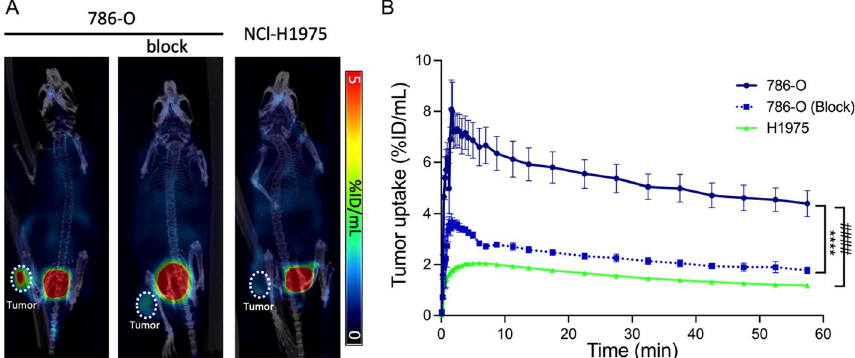
Fig. 3 PET/CT imaging using [ 68 Ga]Ga-NOTA-anti-CD70 VHH fragment— A Representative coronal µPET/ CT images (30–60 min post injection timeframe summed activity, slice thickness 0.78 mm) of mice bearing CD70 high (786-O (left panel) and with block (middle panel)) and CD70 low tumors (NCl-H1975, right panel). B Time-activity curves for radiotracer distribution in the tumors are shown. (%ID/mL % injected dose/ = mL, injected radiotracer dose 4–6.7 µg; ~ 6.4–7.4 MBq/mouse; n 7, data are presented as mean SEM. = = ± **** p < 0.0001; #### p =